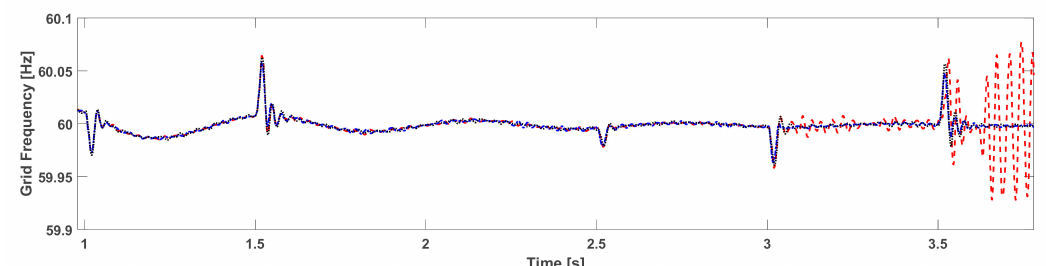
Figure 20. Measured frequency at 11-kV bus during faulty operation (65% power-loss fault).